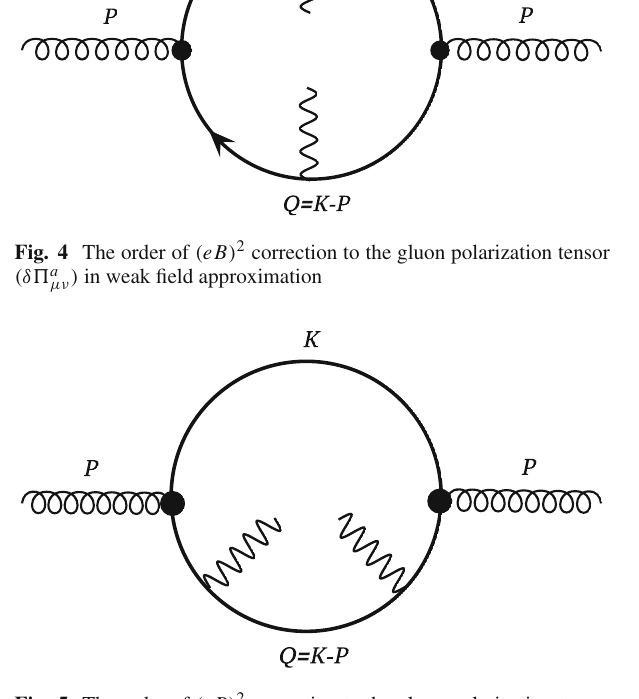
Fig. 5 The order of ( eB ) 2 correction to the gluon polarization tensor (δ(cid:2) b ) in weak field μν